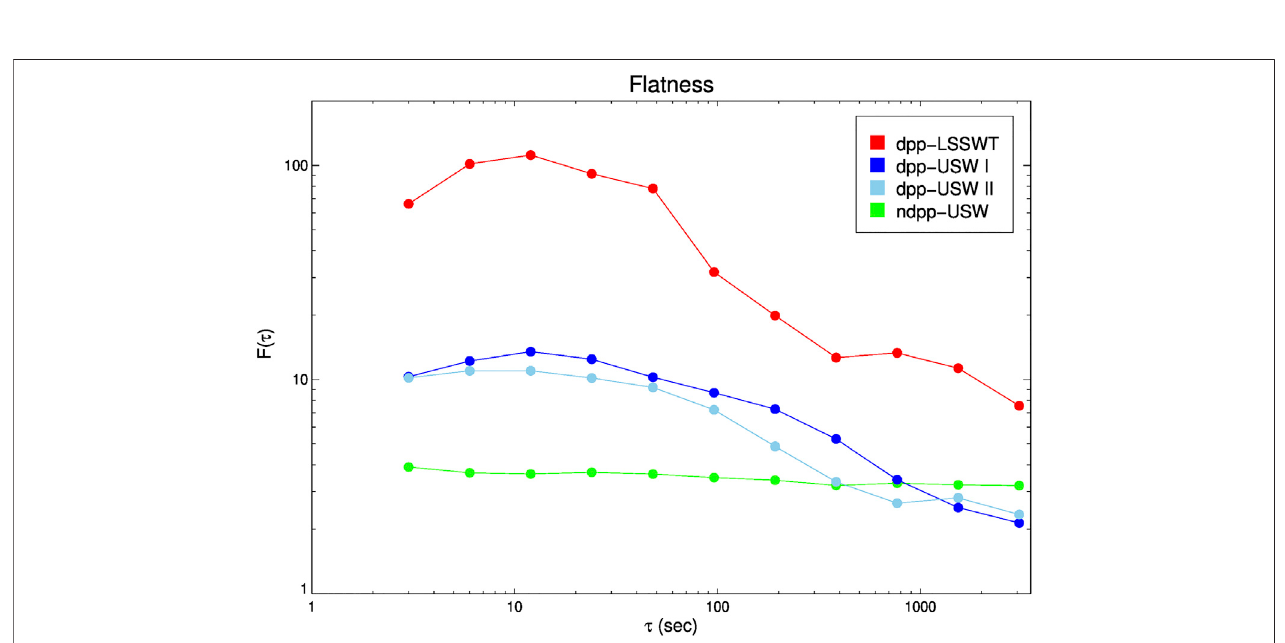
FIGURE 9 | Flatness factor F as a function of different time lags ranging from 3 to 3,072 s, relative to fl uctuations of the plasma density observed in ndpp-USW region(green),dpp-USWIregion(blue),dpp-USW IIregion(skyblue),dpp-LSSWTregion(red),respectively. Thetimeintervals of fi veregionsarepresented in Figure7 .